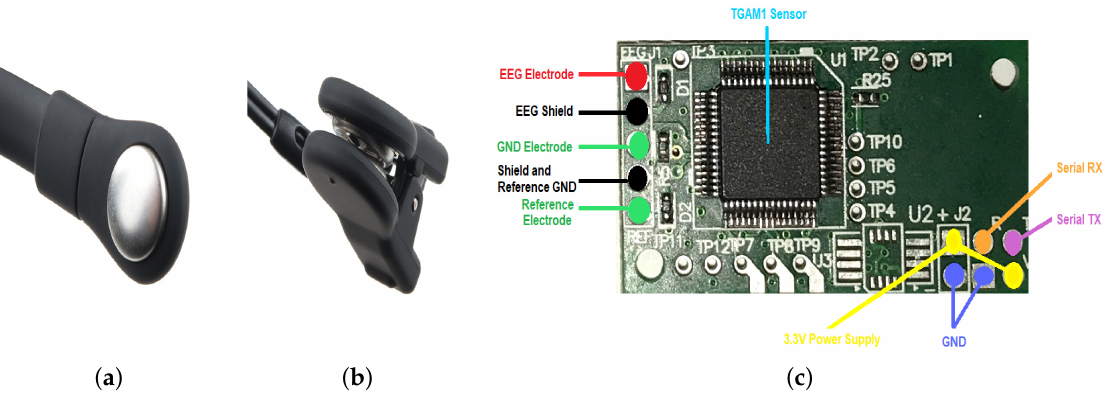
Figure 3. NeuroSky Mindwave Mobile system main parts. ( a ) Dry Electrode. ( b ) Reference and Ground Electrodes. ( c ) EEG biosensor TGAM1 with Communication Module.